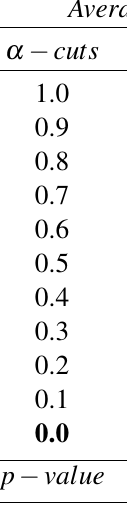
Table 3: Average Rankings of the α − cuts with Friedman test